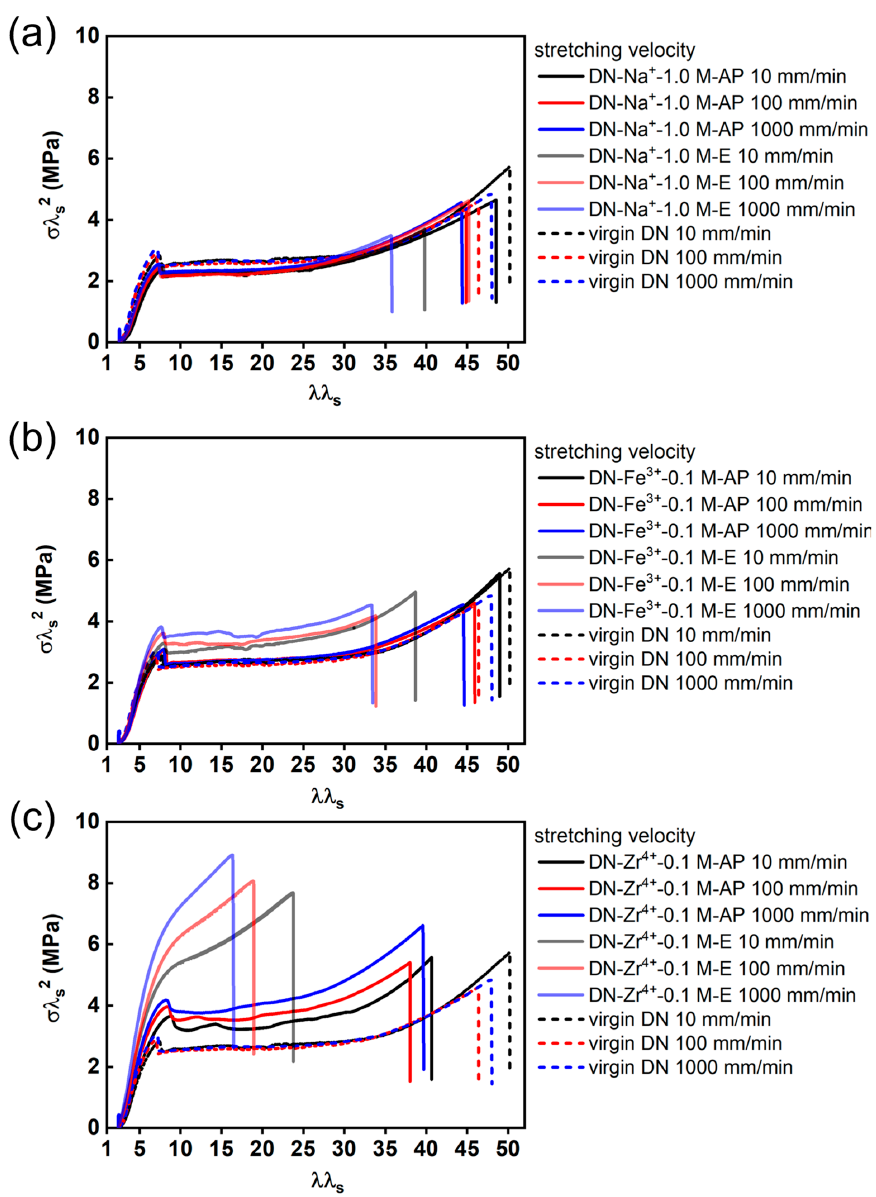
Figure 7. ( a – c ) The rescaled stress σλ s2 –rescaled stretch ratio λλ s curves for DN hydrogels coordinated with Na + ( a ), Fe 3+ ( b ), and Zr 4+ ( c ) as metal ions under different deformation rates ranging from 10 to 1000 mm/min.